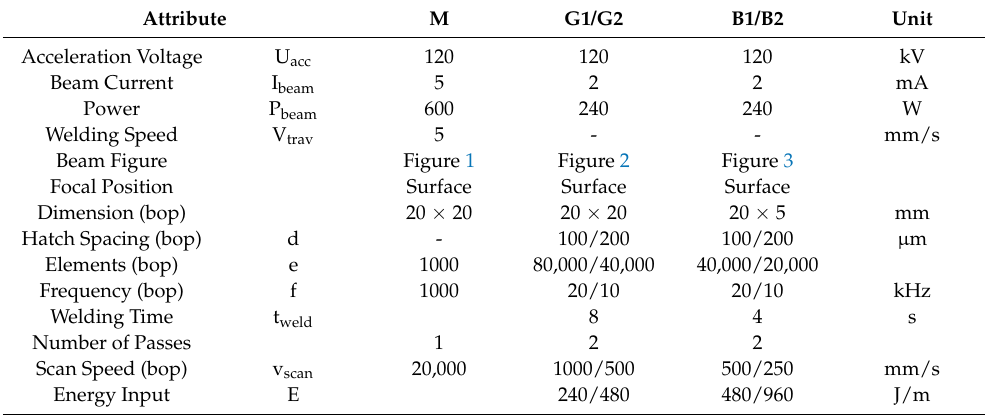
Table 1. Summary of input and beam oscillation parameters to achieve: M, plain EB molten and solidified surface with α ’ martensitic microstructure; G1/G2, micro-grooves; B1/B2, bridge